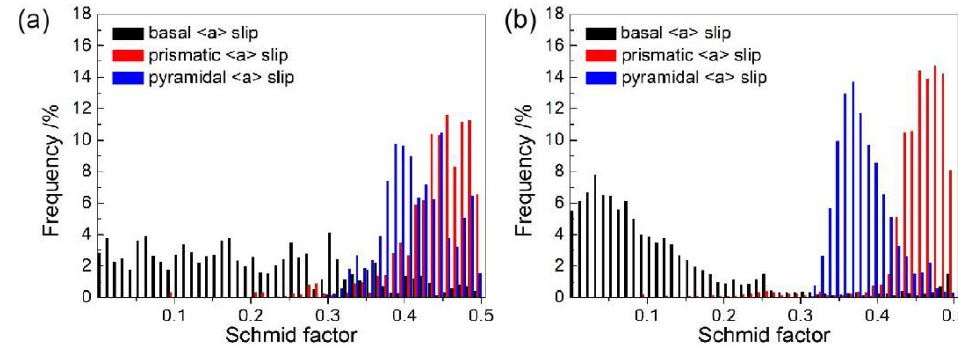
Figure 12. Schmid factors of Ti-6Al-4V alloy deformed by 90% at ( a ) 850 °C and ( b ) 950 °C.